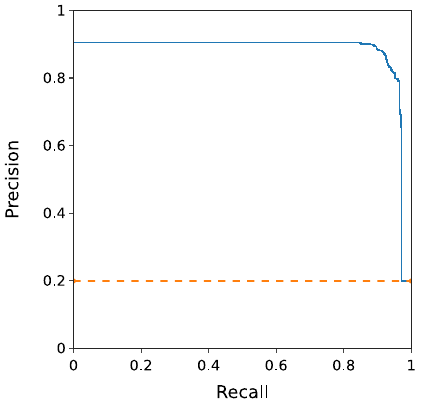
FIG. 3. Interpolated precision-recall curve for the BPM thresh- old on AMPL-based candidates. The best F 1 score is 0.897, at a BPM anomaly score threshold of 2.848, corresponding to an accuracy of 96%. The dashed line is the precision-recall curve for a random classifier. Note that recall here does not include anomalies missed by the AMPL threshold and is only an upper limit on the recall for the full